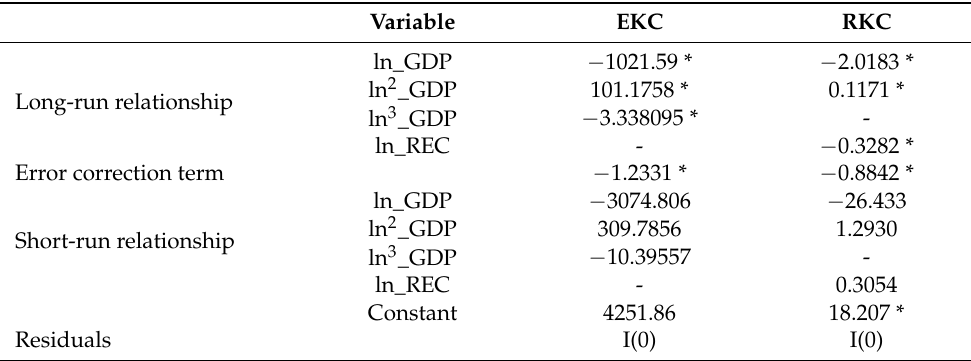
Table 5. Pool mean groups (PMG) regressions in basic EKC and RKC for V4 and Baltic countries 1 . Variable EKC RKC